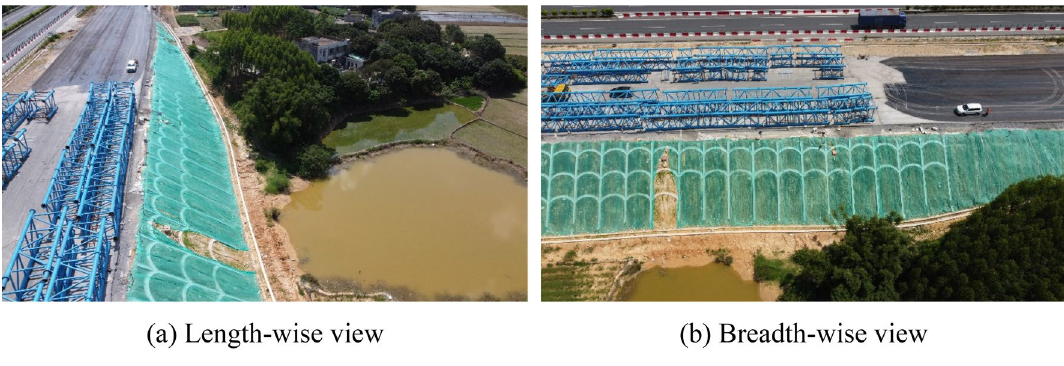
Figure 16. Bird’s eye views of the finished